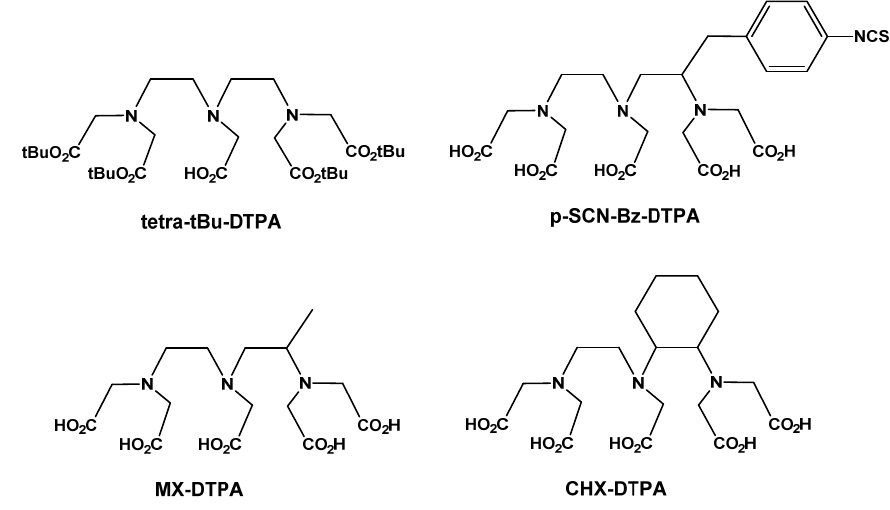
Figure 6. Structures of four DTPA derivatives. Tetra- t- Bu-DTPA, containing the protecting groups required to ensure no double substituted products form compared to p -SCN-Bz- DTPA which highlights the use of side chains in order to improve binding of the